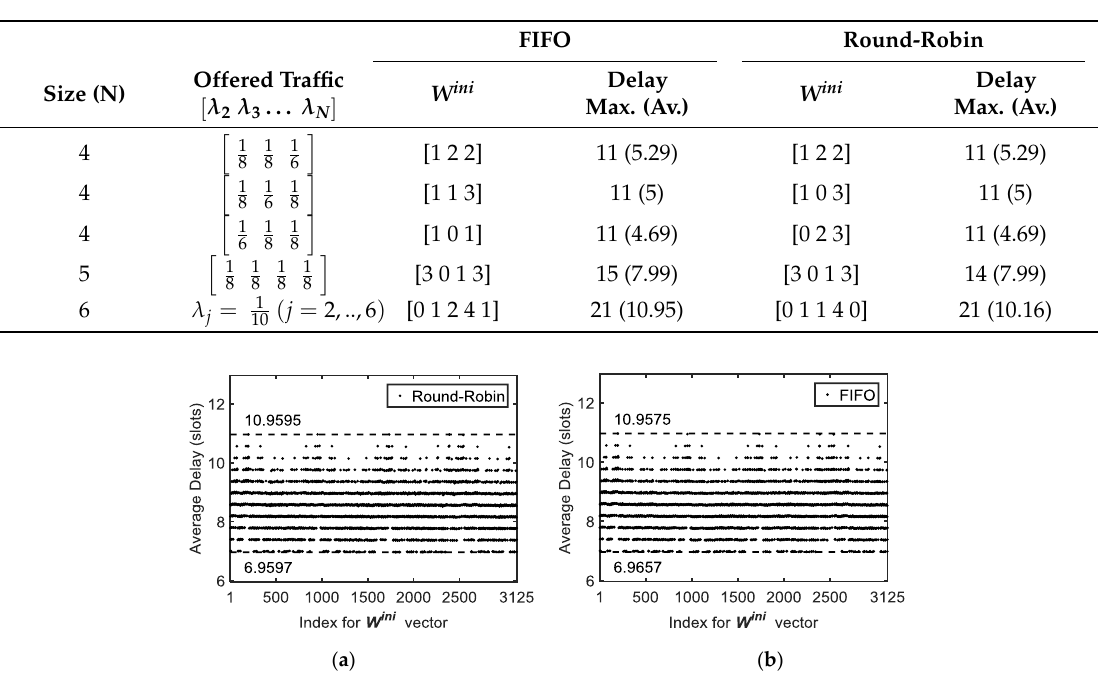
Table 4. Maximum delay of the optimal scheduling (slots) Round-Robin vs. FIFO. Simulation time: 1000 time slots.